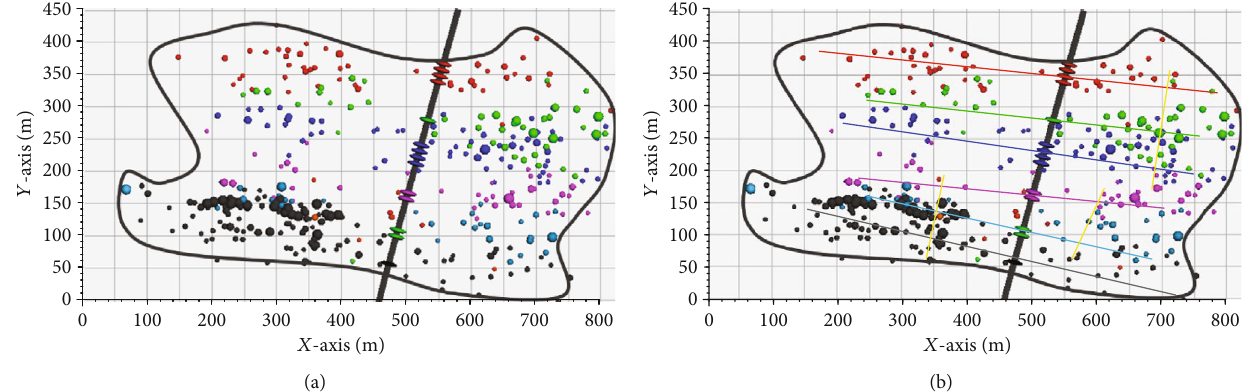
Figure 1: (a) The microseismic detection diagram. (b) The fracture network explained by the microseismic detection.